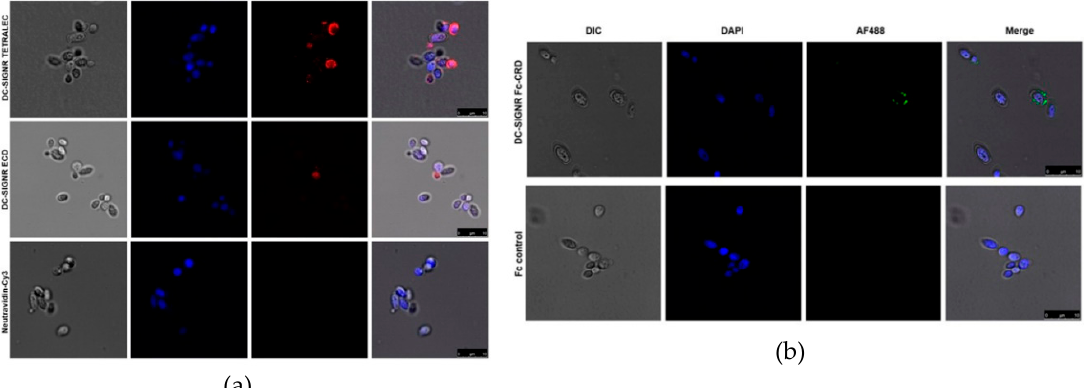
Figure 8. Binding of heat-killed C. albicans to di ff erent DC-SIGNR constructs using confocal microscopy. ( a ) Recognition of HKCA cell wall by DC-SIGNR TETRALEC (upper panels), DC-SIGNR ECD (middle panel) or NeutrAvidin-Cy3 (negative control, lower panels). ( b ) DC-SIGNR Fc-CRD binding to HKCA (upper panels) or Fc (negative control, lower panels). C. albicans cell wall was visualized by di ff erential interference contrast (DIC). C. albicans DNA was stained using DAPI (in blue), while CLR-Fc constructs were detected using the AF488-conjugated secondary antibody (in green) and Cy3 detection of the DC-SIGNR-Cy 3 constructs is shown in red. Three random pictures were taken per independent experiment ( n = 3). Scale bar indicates 10 µ